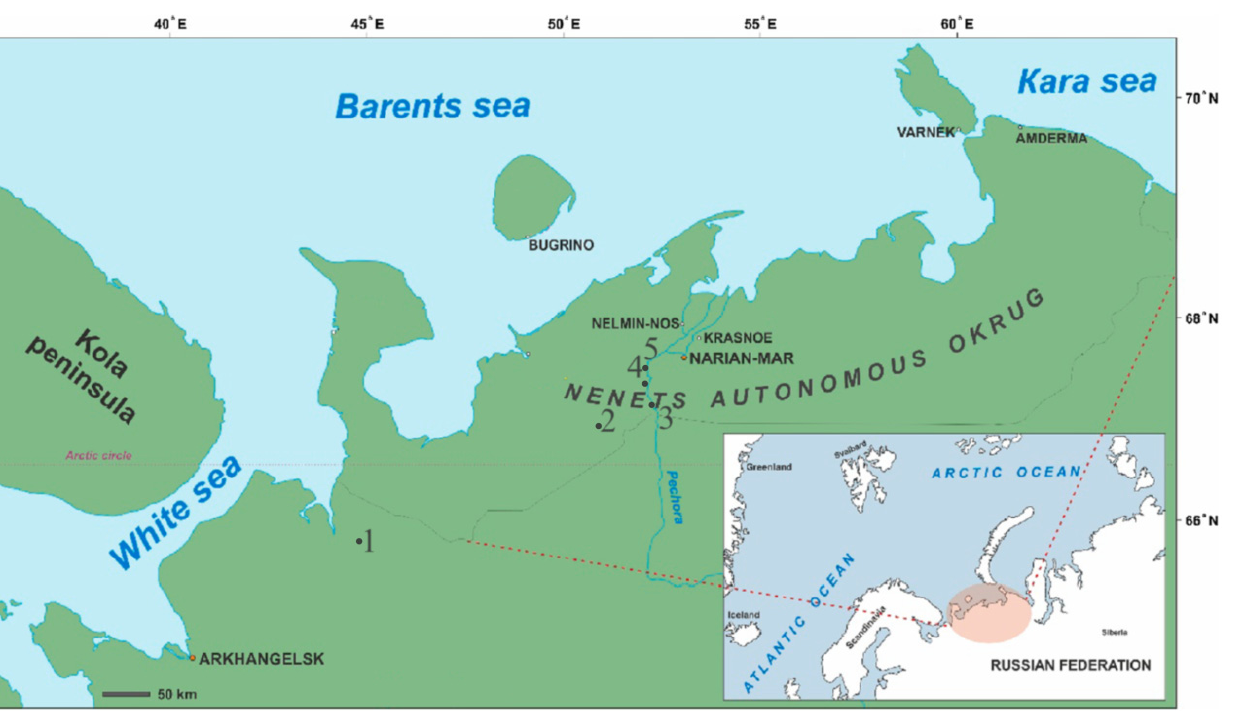
Figure 1. Sites for sampling mollusk shells in the European North of Russia. 1: river Peza (vicinities of the village of Bychye), 2: river Sula (near the village of Kotkino), 3: Vastyansky Kon’ (river Pechora), 4: Khongurei (river Pechora), 5: location 10 km north-west of the village Oksino, river